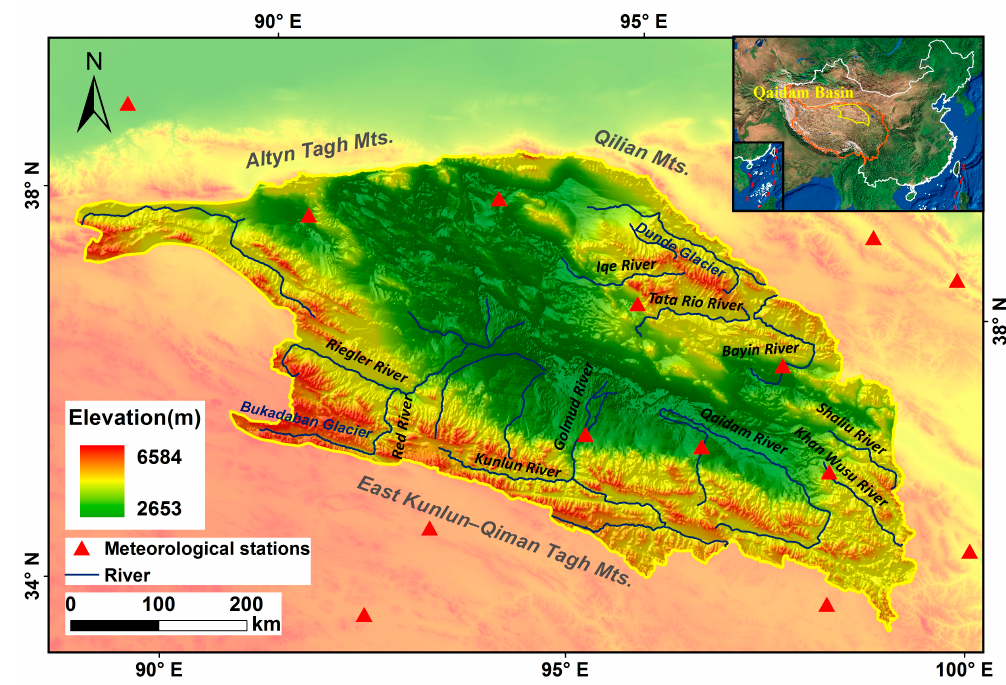
Figure 1. The geographical situation of the Qaidam Basin (QB) in northern Tibetan Plateau, China.